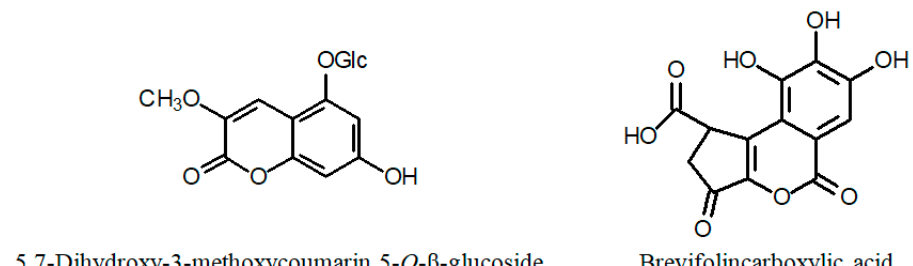
Figure 7. Chemical structures of (iso)coumarins of the genus Cuphea .